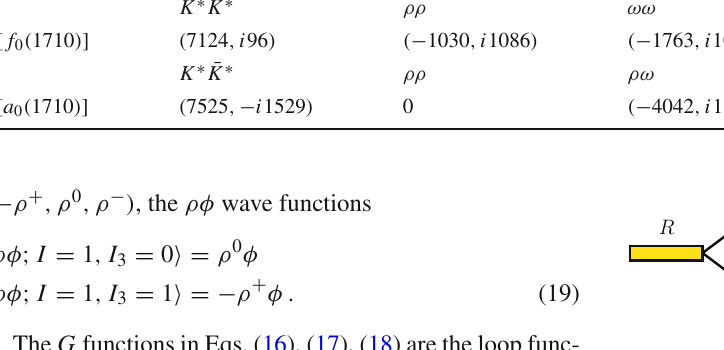
Fig. 6 Amplitude for R → K ¯ K for a resonance build up from the V i , V (cid:7) channels. Diagrams with ¯ K K instead of K ¯ K in the final state i appear with ρ,ω,φ vector mesons but not for the V i , V (cid:7) the branching ratio for the K + K 0 to the a 0